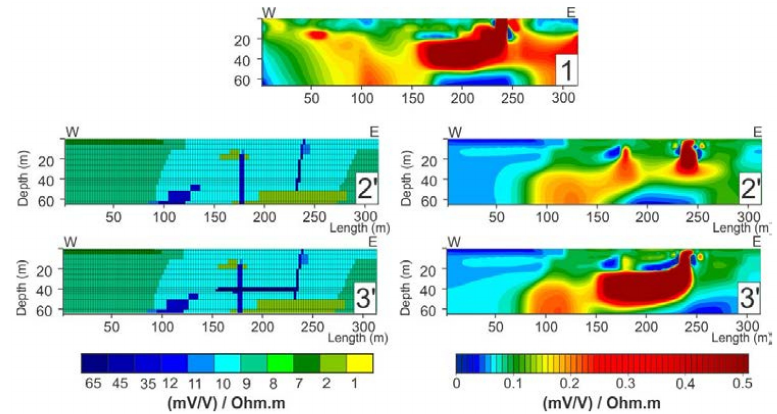
Figure 13. 2D modelling of the IP data in the case of Profile 2 (1) with Res2DMOD [54]. Inversion of the two parallel lodes model (2) and the horizontal lode model (3) are represented at (2 (cid:48) ) and (3 (cid:48) ). As seen in (2 (cid:48) ), the presence of only the two conductive lodes, as assumed in the 3D model, cannot explain the low chargeability anomaly (1). The presence of a horizontal conductive layer between the two vertical lodes (3) is more appropriate to explain the geophysical signature of